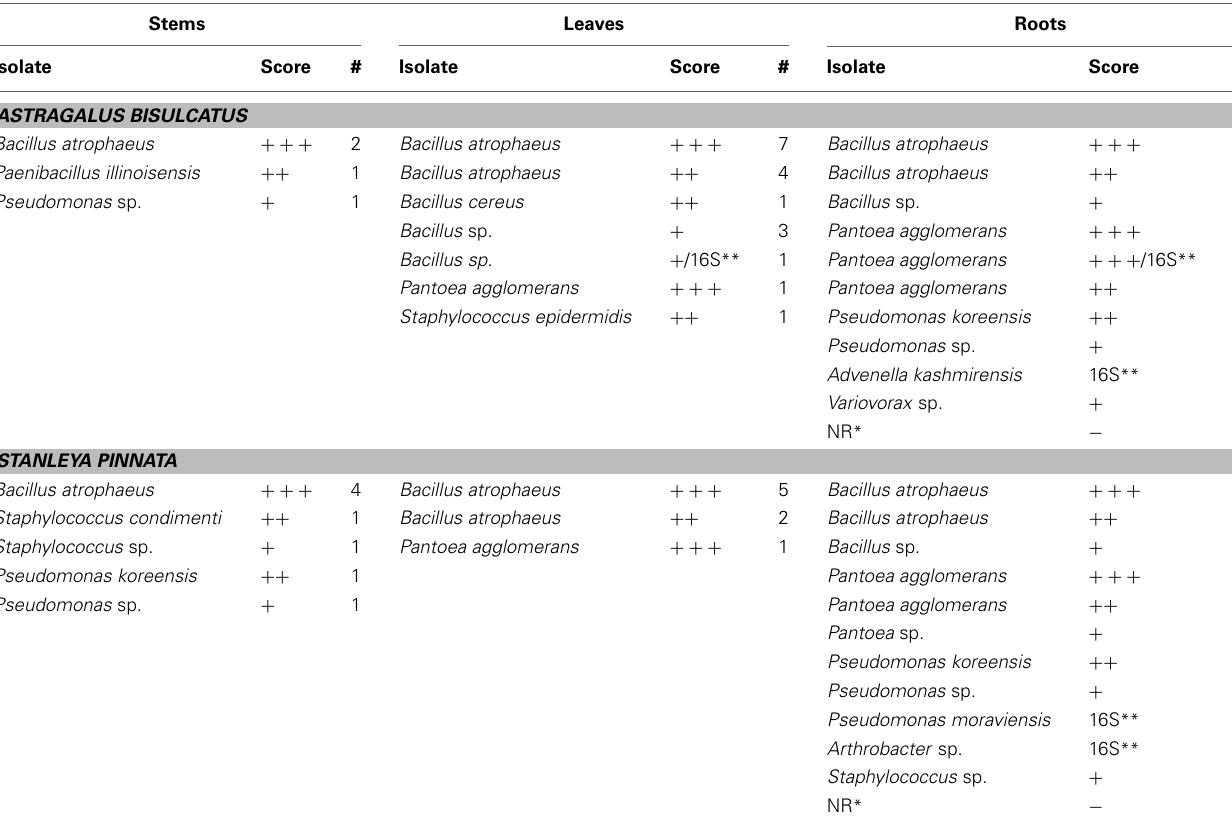
Table 1 | Bacterial isolates from hyperaccumulators Astragalus bisulcatus and Stanleya pinnata . Stems Leaves Roots Isolate Score # Isolate ASTRAGALUS BISULCATUS